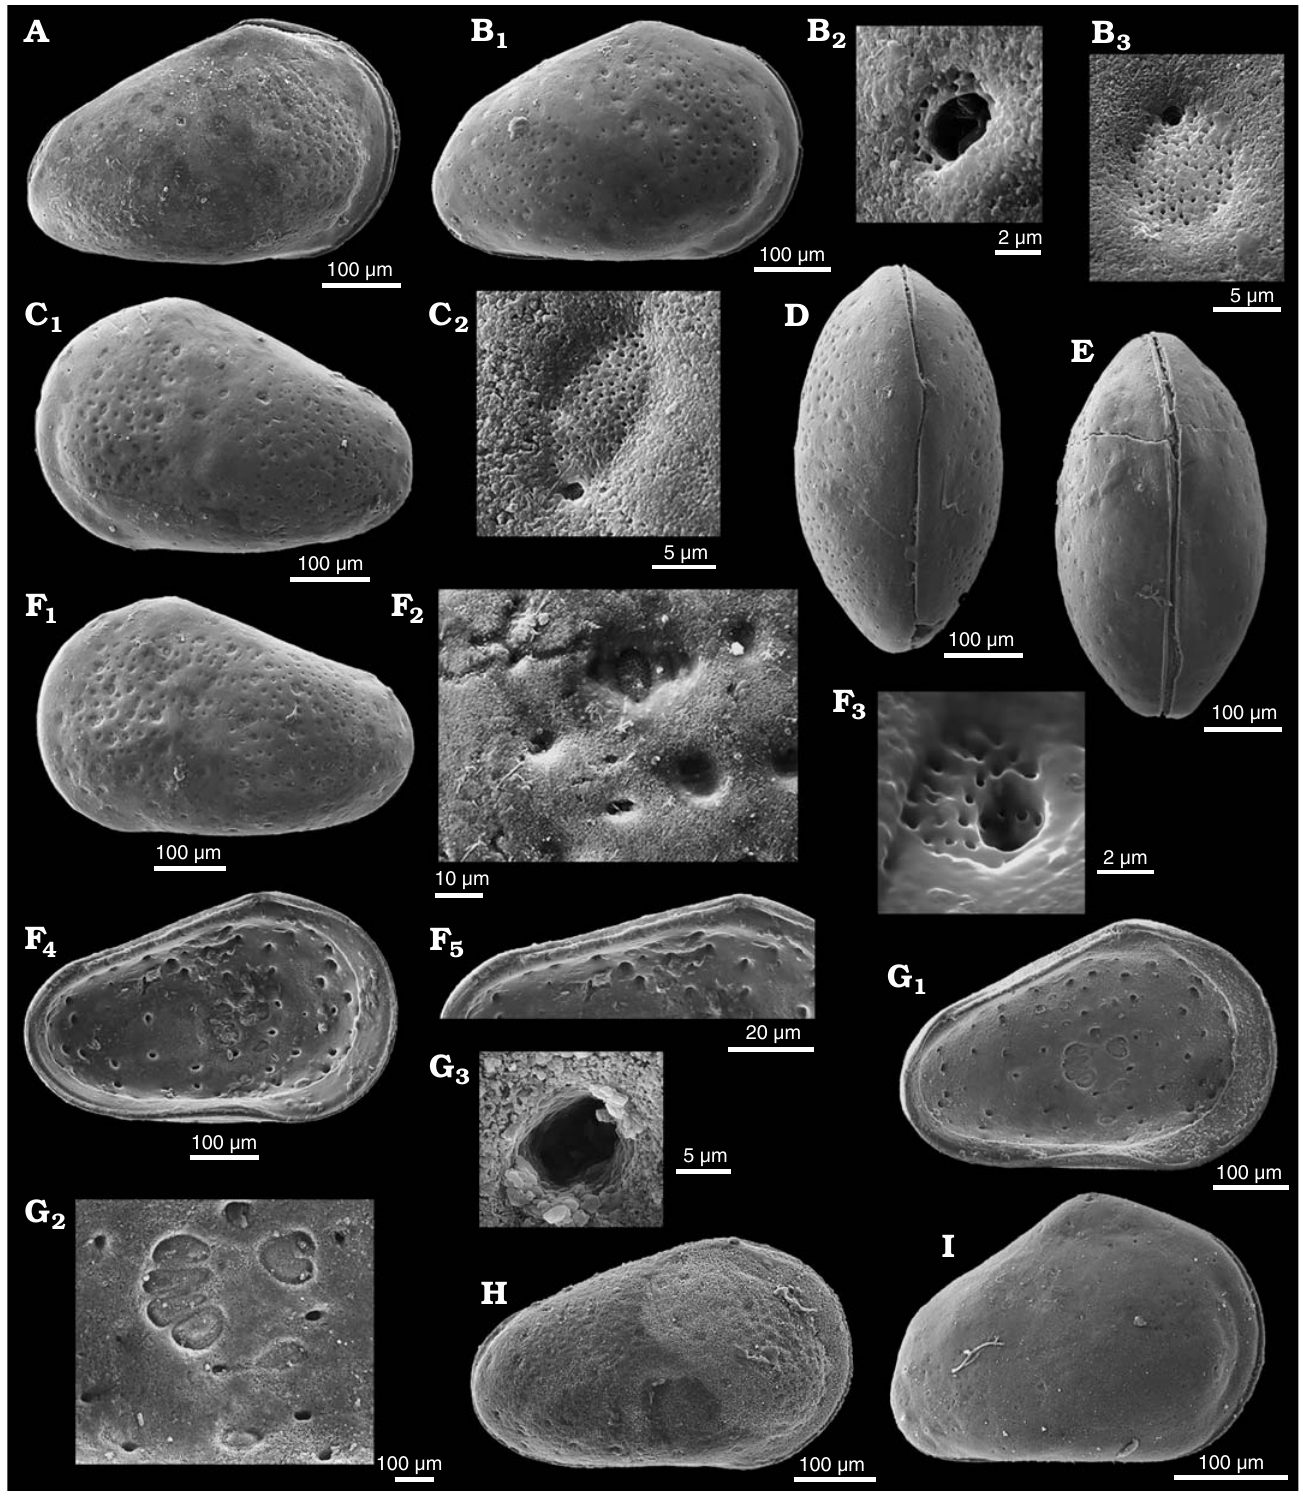
Fig. 12. Cytherid ostracod Minyocythere angulata sp. nov. from Borehole Hambühren WA2, 177–180 m (A, H), 203–206 m (B–E), 203 m (F, G), NW Germany, Upper Aalenian (Braun Jura β ). A . Paratype, SMF Xe 23732, female carapace in right view. B . Paratype, SMF Xe 23733, female right valve in ex- ternal view (B 1 ), micro sieve-type pore canals (StPC-m) (B 2 ), and round macro sieve-type normal pore canals (StPC-M) (B 3 ). C . Paratype, SMF Xe 23734, female left valve in external view (C 1 ), elongate StPC-M (C 2 ). D . Paratype, SMF Xe 23735, female carapace in dorsal view. E . Paratype, SMF Xe 23736, female carapace in ventral view. F . Holotype, SMF Xe 23737, male left valve in external (F 1 ) and internal (F 4 ) views, ornamentation and StPC-M and StPC-m (F 2 ), StPC-m (F 3 ), hinge (F 5 ). G . Paratype, SMF Xe 23738, female left valve in internal view (G 1 ), muscle scars (G 2 ), StPC-m (G 3 ). H . Paratype, SMF Xe 23740, male carapace in right view. I . Paratype, SMF Xe 23739, A-2? juvenile right valve in external